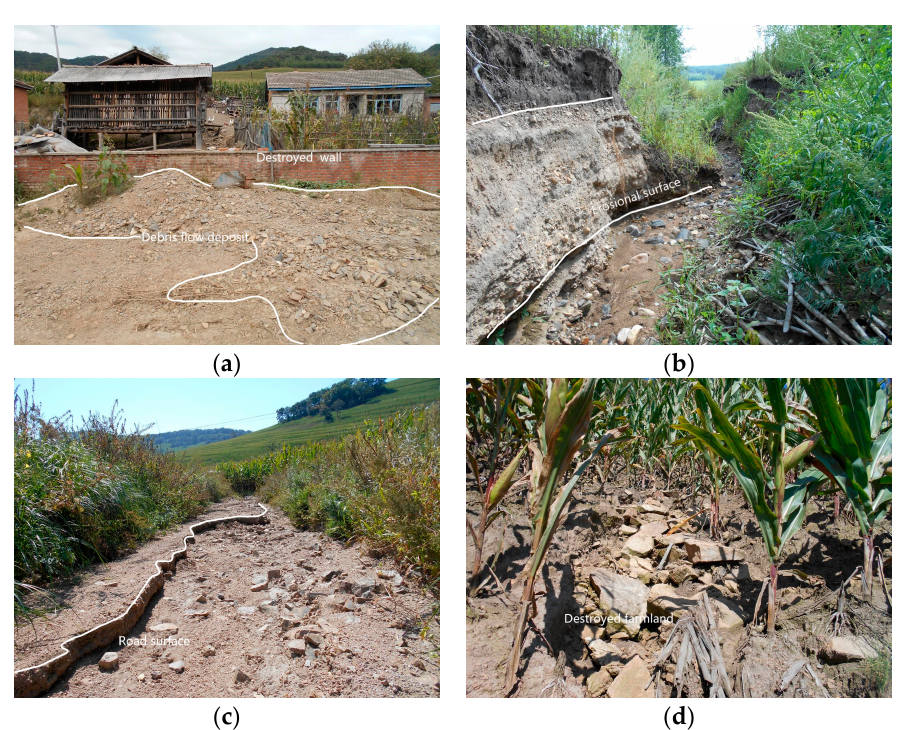
Figure 3. Debris flow disasters identified in the field: ( a ) debris flow deposit and destroyed wall; ( b ) erosional surface; ( c ) destroyed road; and ( d ) destroyed farmland.